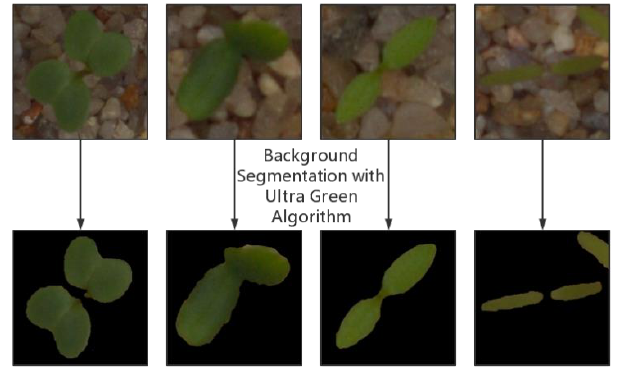
Figure 2. Example of single-leaf binary images after partial processing.